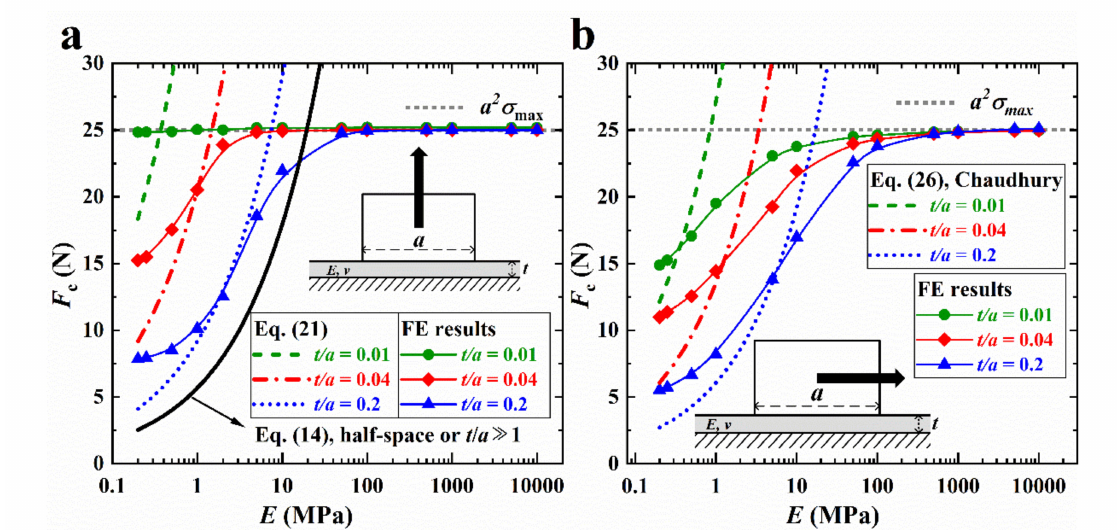
Figure 7. 3D FE simulation results: F c versus E for ( a ) normal and ( b ) shear separation with t/a = 0.01, 0.04, and 0.2 on a linear-log